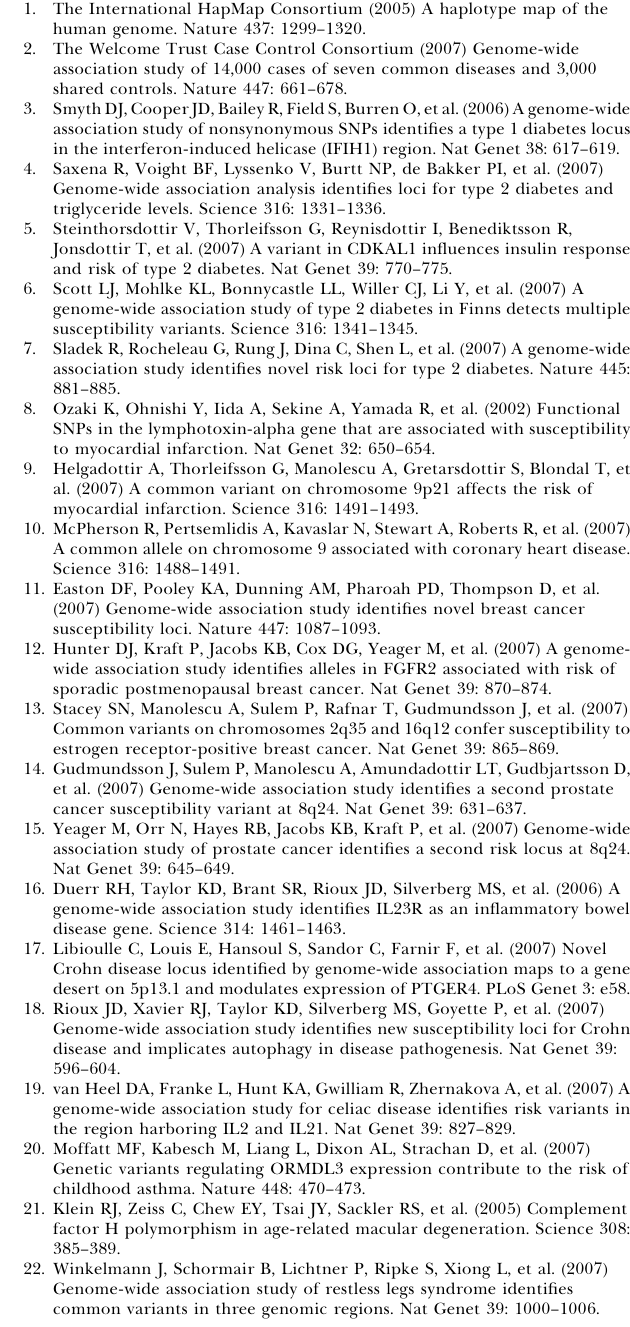
Figure 6. CNV Characterization Strategies (A) Scales of resolution at the nucleotide level and maximum number of loci interrogated by the different methods (only the most widely used approaches are shown). (B) Diagram of different approaches in CNV analysis, either at the genome-wide scale or at individual/multiplex loci. Arrows indicate the deeper analysis that is needed after initial detection by one methodology or another. DASH, dynamic allele-specific hybridization [80]; PRT, paralogue ratio test [81]; MAQ, multiple amplicon quantification [82]; qPCR, quantitative